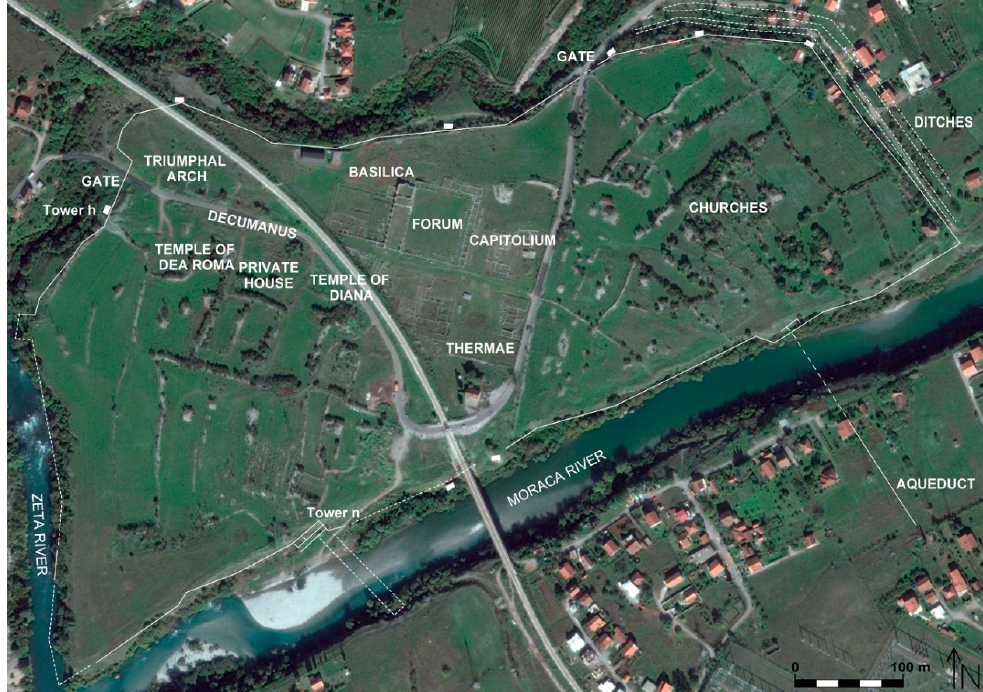
Figure 5. Doclea: satellite image of the urban area with indication of architectonical elements and road patterns based on Sticotti's researches [66] (modified from ©2018 Google Image).